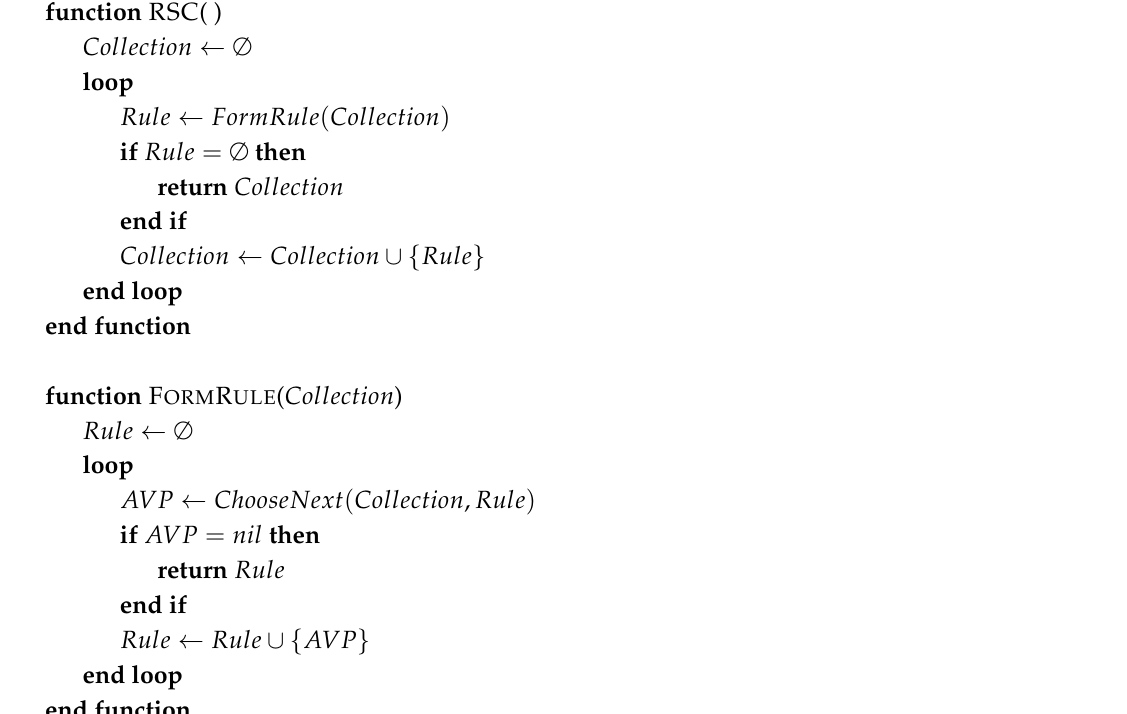
Algorithm 1 Relaxed Separate-and-Conquer (RSC) Rule Learning